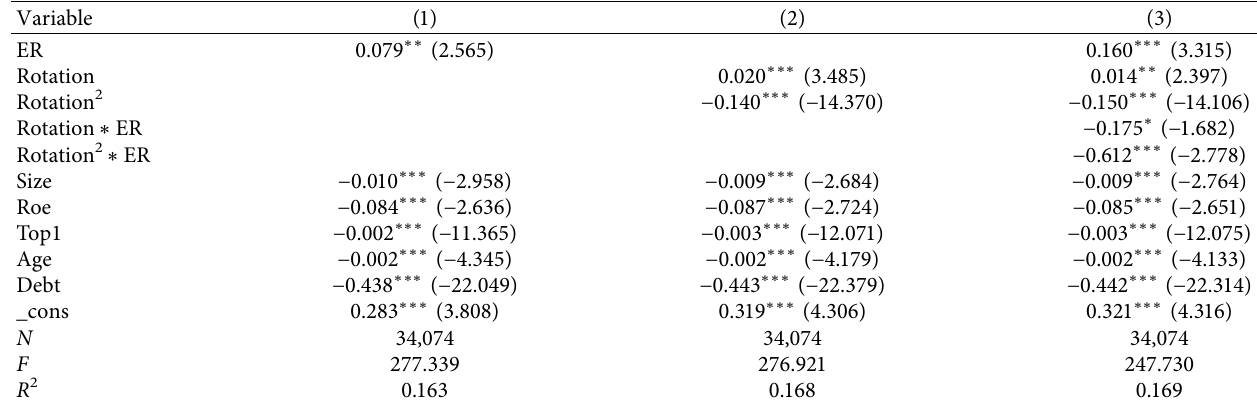
Table 8: Regression coefficient tables.